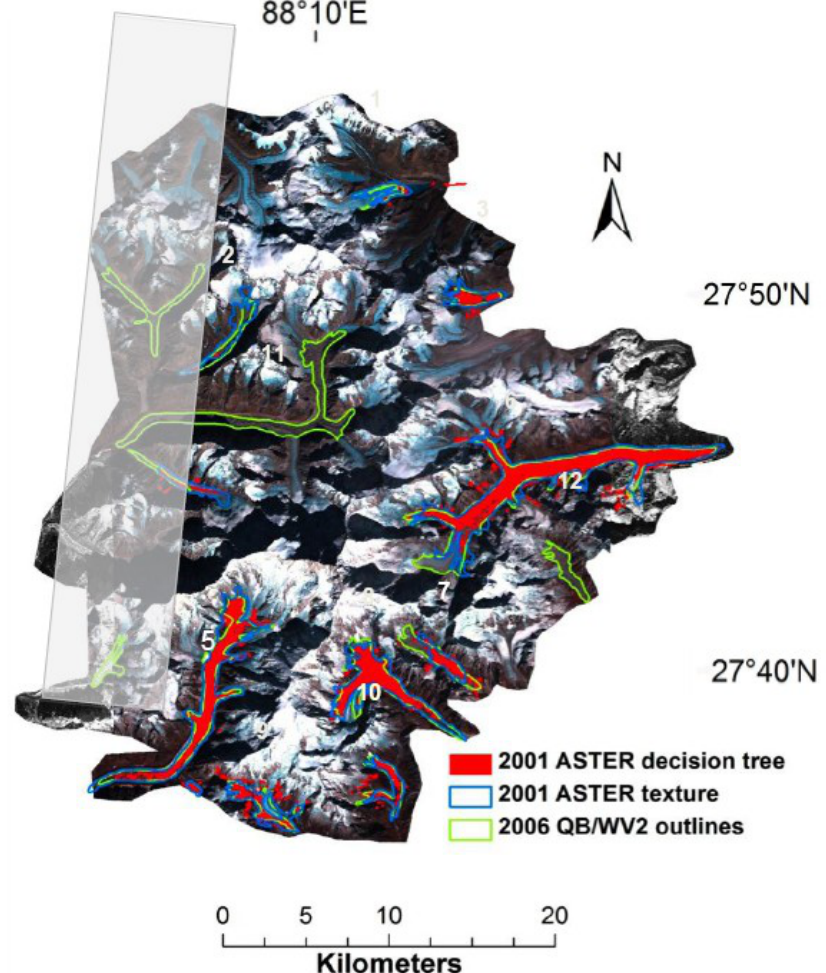
Figure 10. Comparison of debris covered glacier outlines derived from the decision tree with manually derived QB-WV2 outlines, shown on a color composite (QB bands